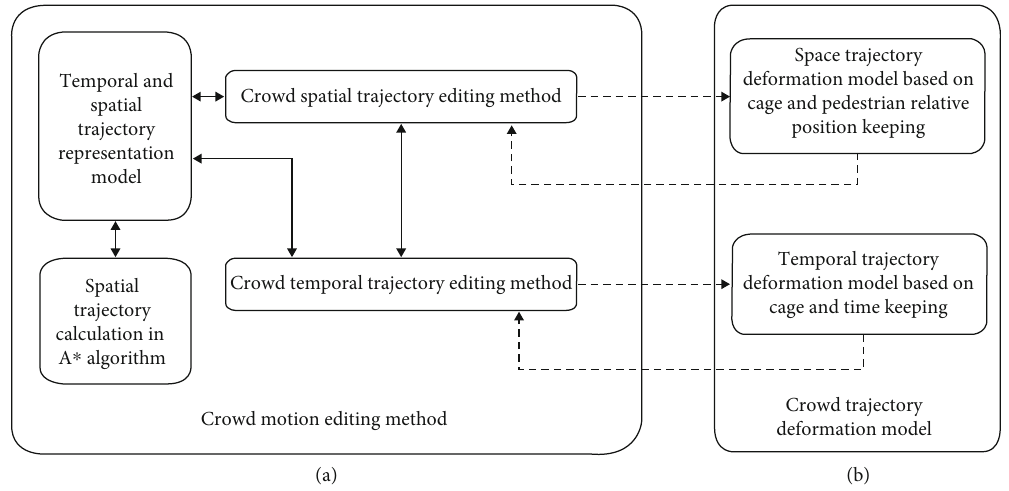
Figure 1: Architecture overview of the crowd motion editing model.